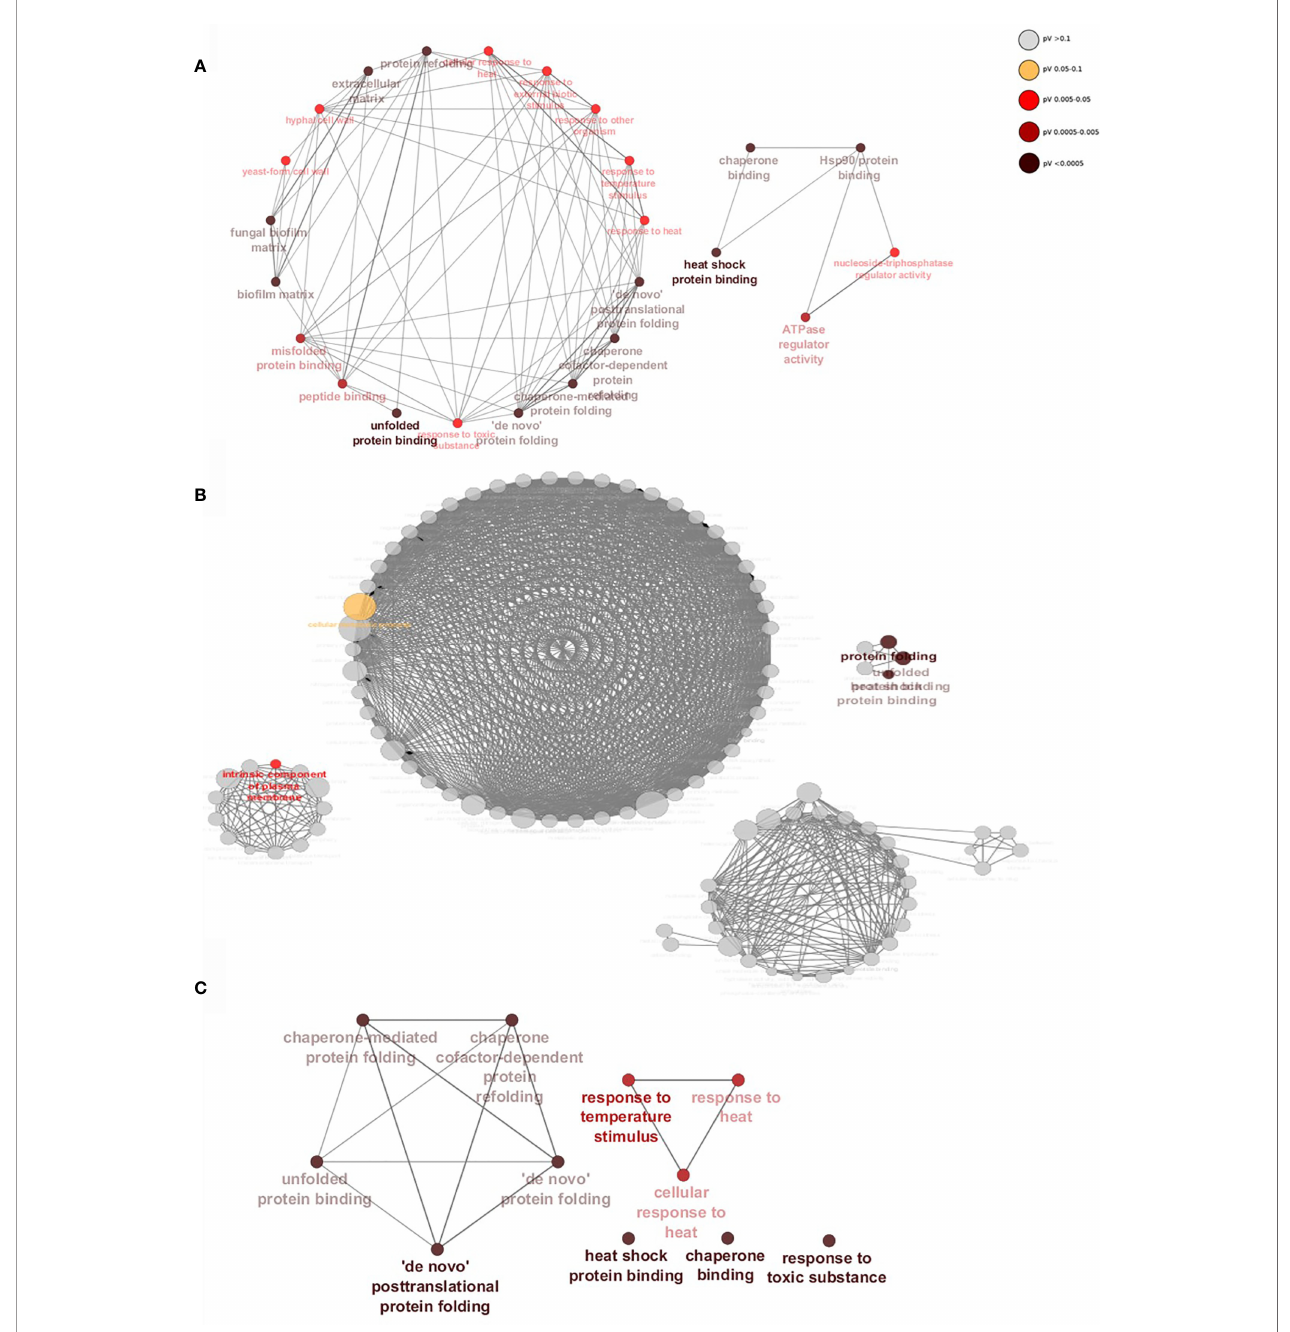
FIGURE 5 | Staphylococcus aureus induces signi fi cant upregulation of bio fi lm-associated genes when binding to Als3. Gene networks show interactions between upregulated genes speci fi c to (A) WT, (B) ALS3 and (C) ECE1 null mutant dual-species, mature bio fi lms. Genes of similar function are grouped together to form nodes (circles) and nodes with similar functions are linked by edges (lines). Nodes are coloured by levels of signi fi cance and node size increases with the number of genes involved in each function. Networks were created using